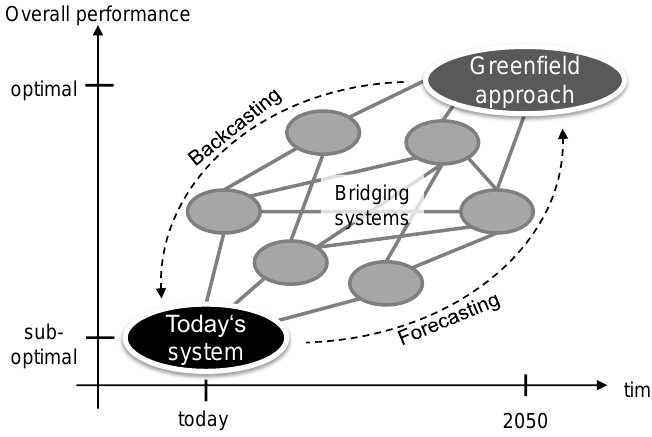
Figure 1. Vision of transition paths to final greenfield optimality, adapted from